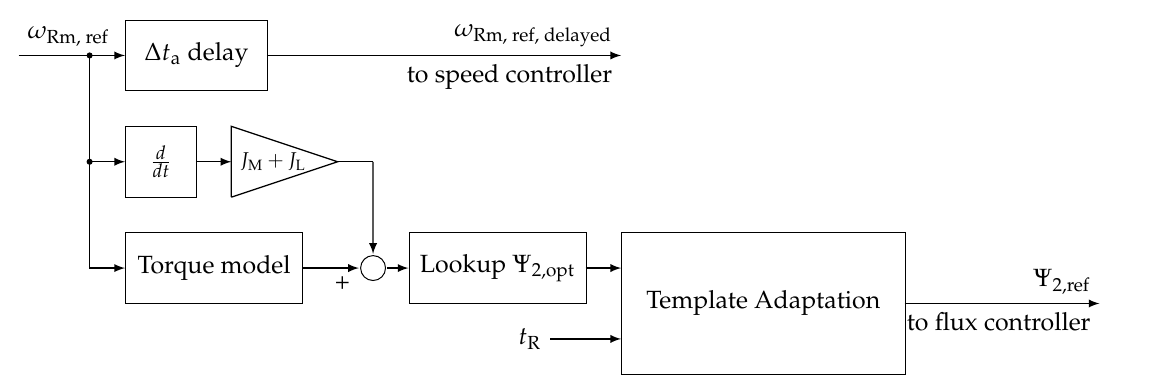
Figure 8. Template adaptation